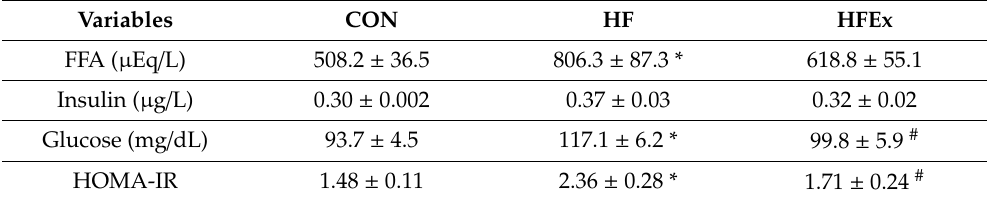
Table 1. Average level of blood parameters at conclusion of 6 weeks treatment.